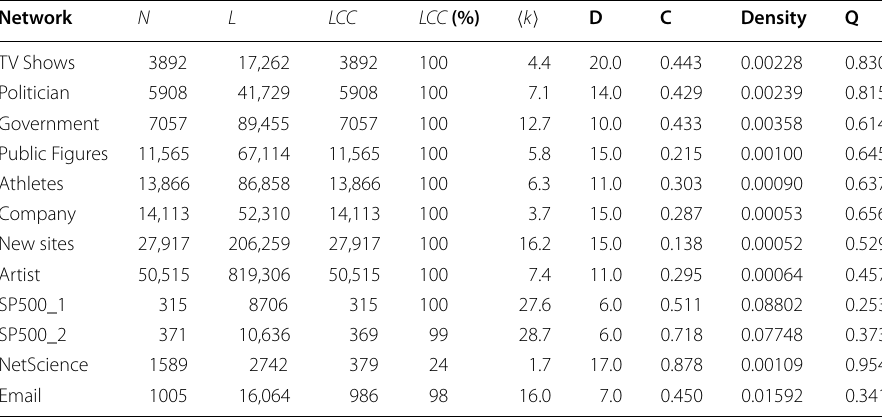
To compute modularity Q, a clustering step was executed in priori using the popular fast‑greedy modularity optimization algorithm (Clauset et al. 2004)